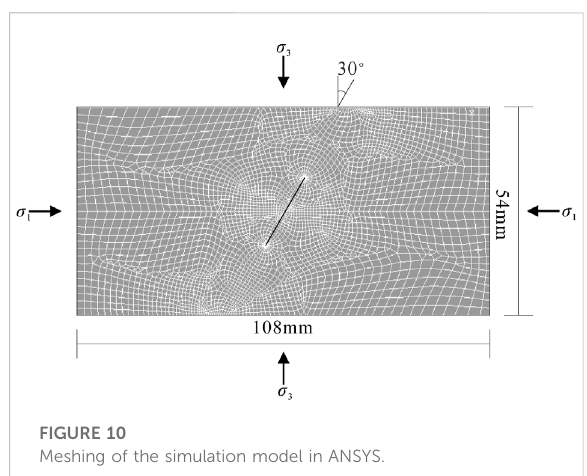
FIGURE 10 Meshing of the simulation model in